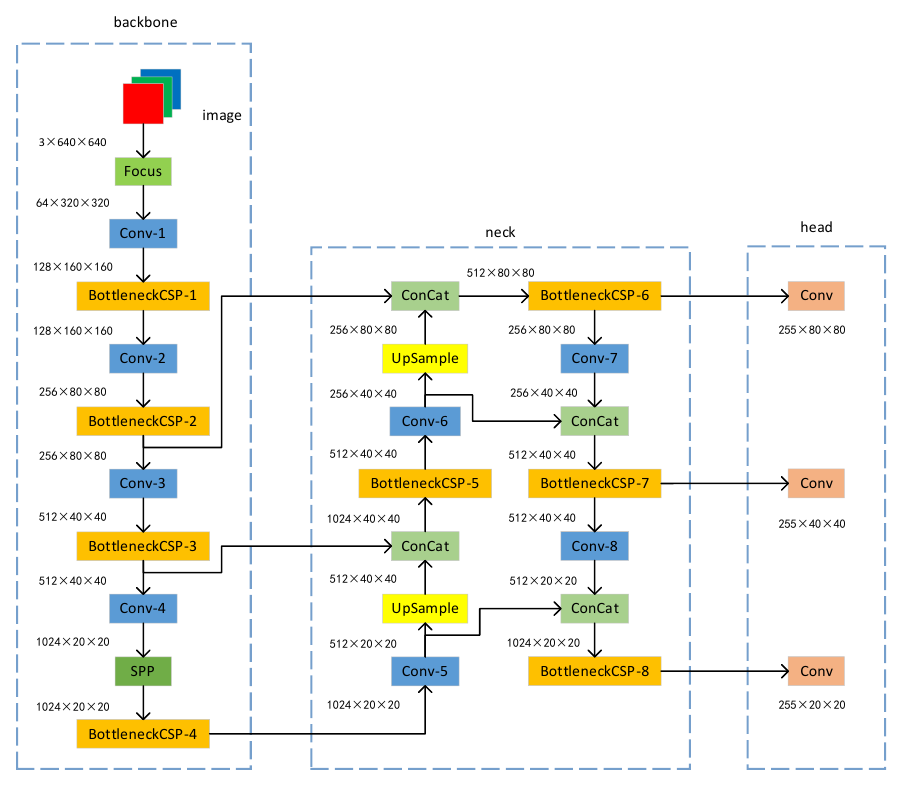
Figure 1. Structure of the YOLOv5s network.